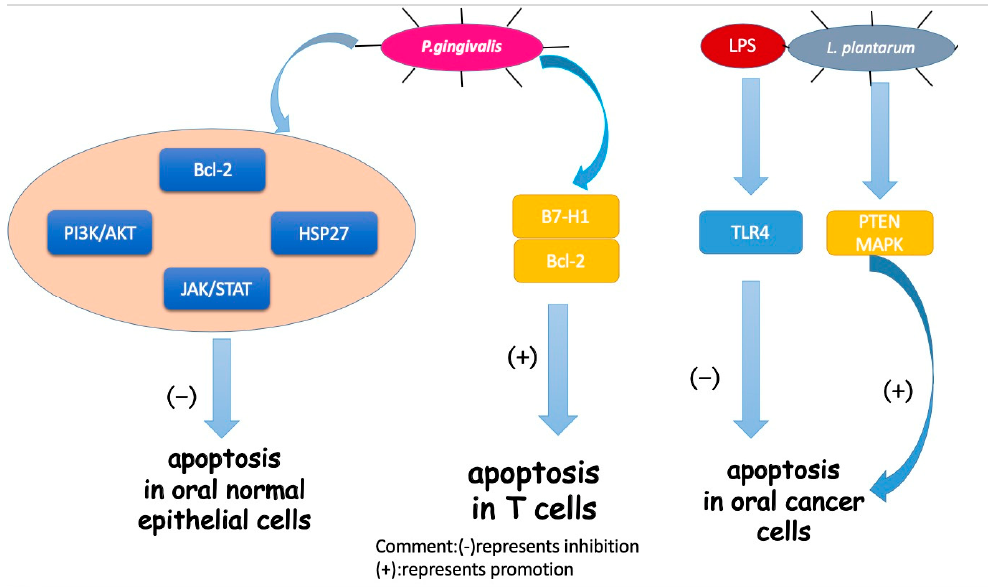
Figure 2. Mechanisms for how oral bacteria influence cell apoptosis.